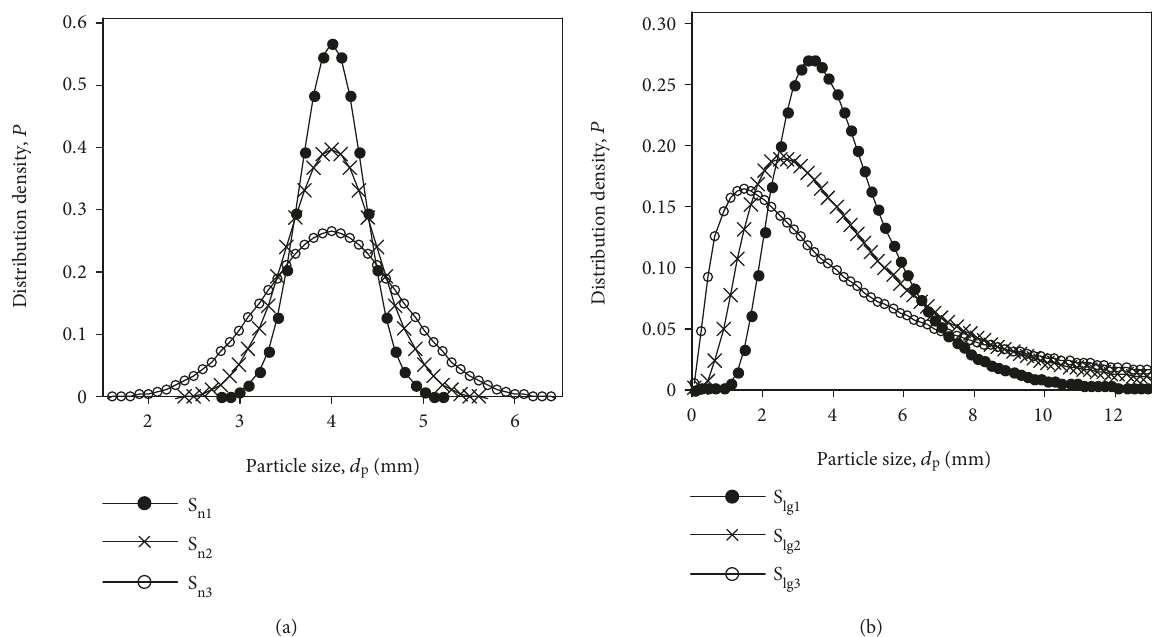
, S , and S with lg1 lg2 lg3